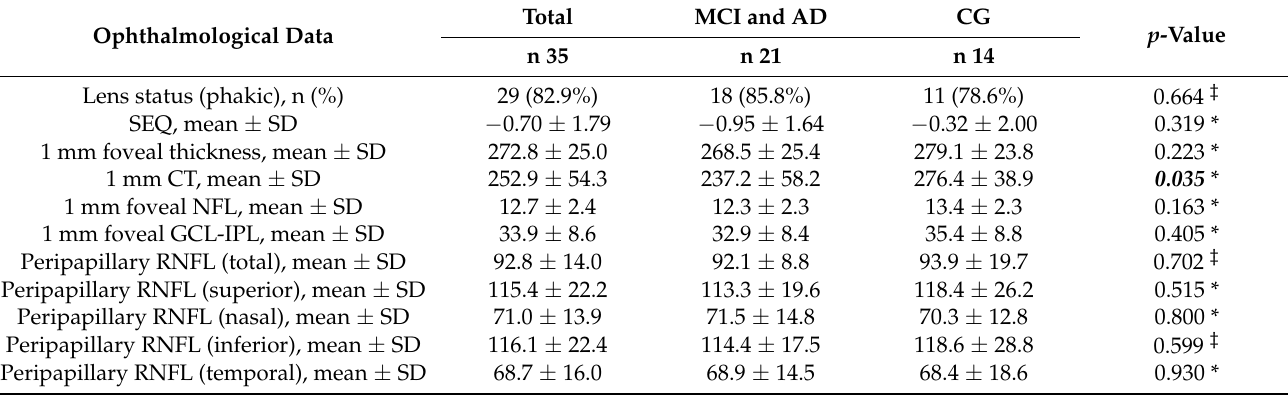
Table 3. Clinical and Optical coherence tomography (OCT) data of enrolled